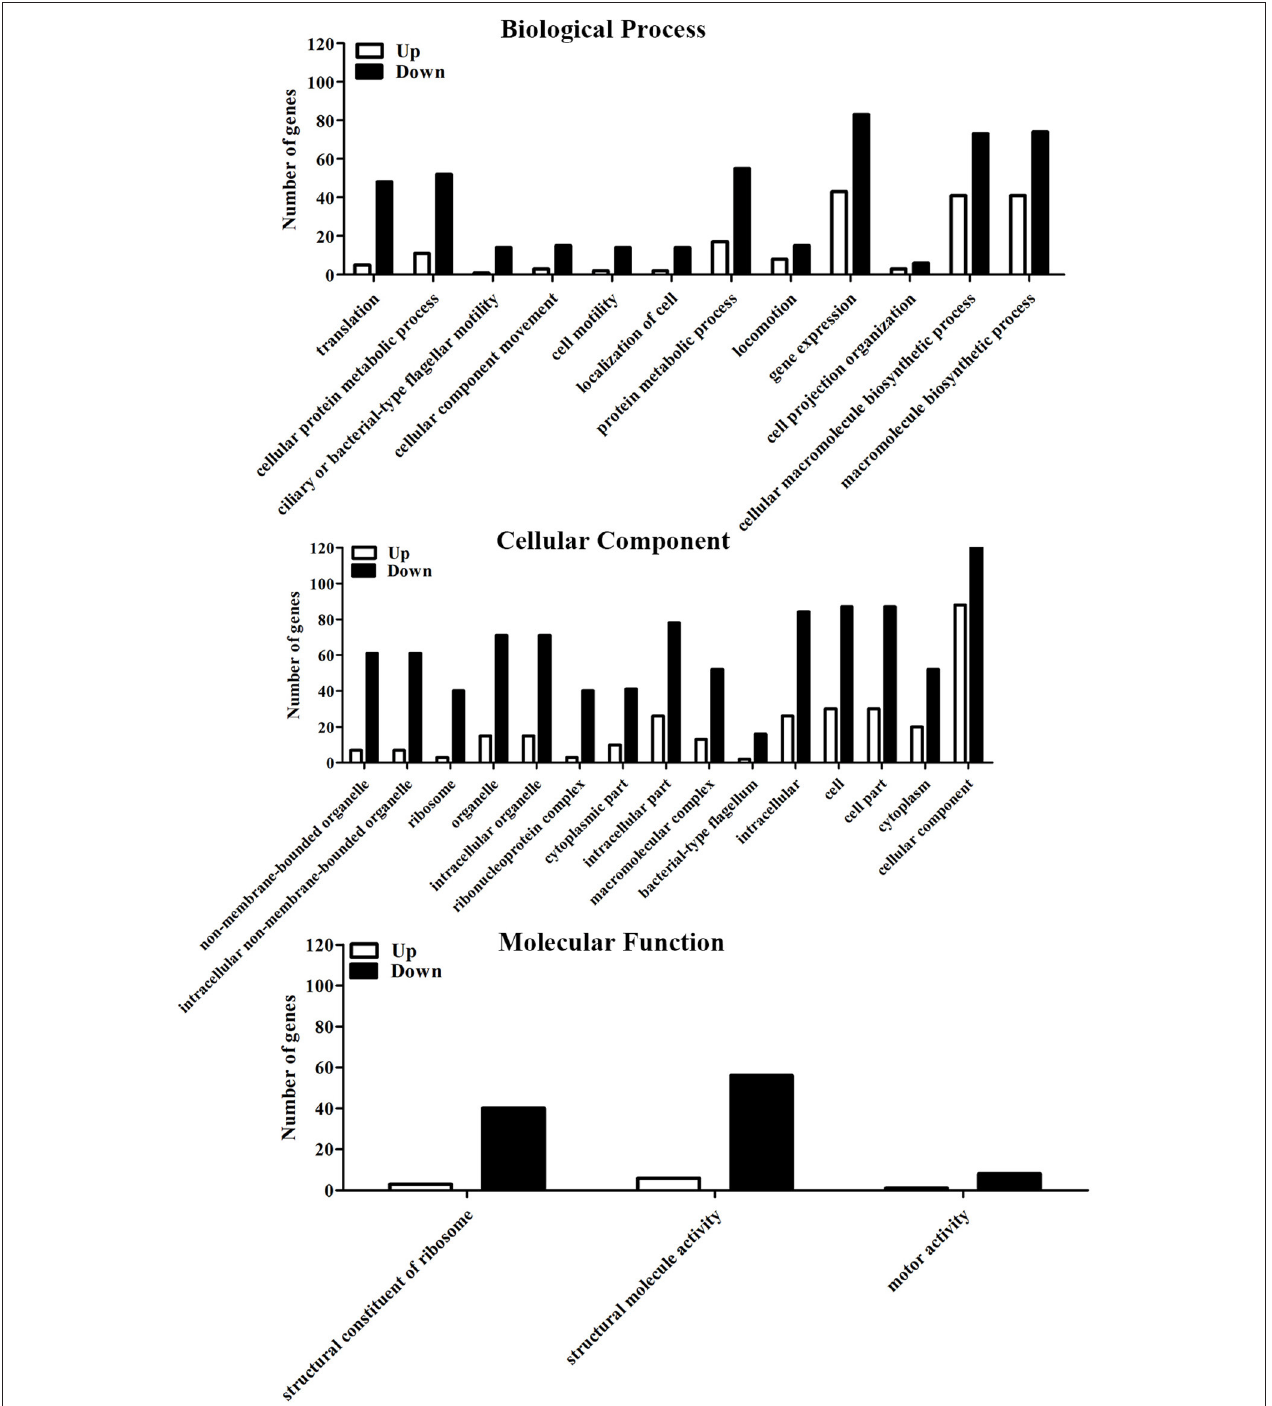
FIGURE 5 | GO analysis of differential expression genes to the initial and the 6-months starved V. anguillarum .